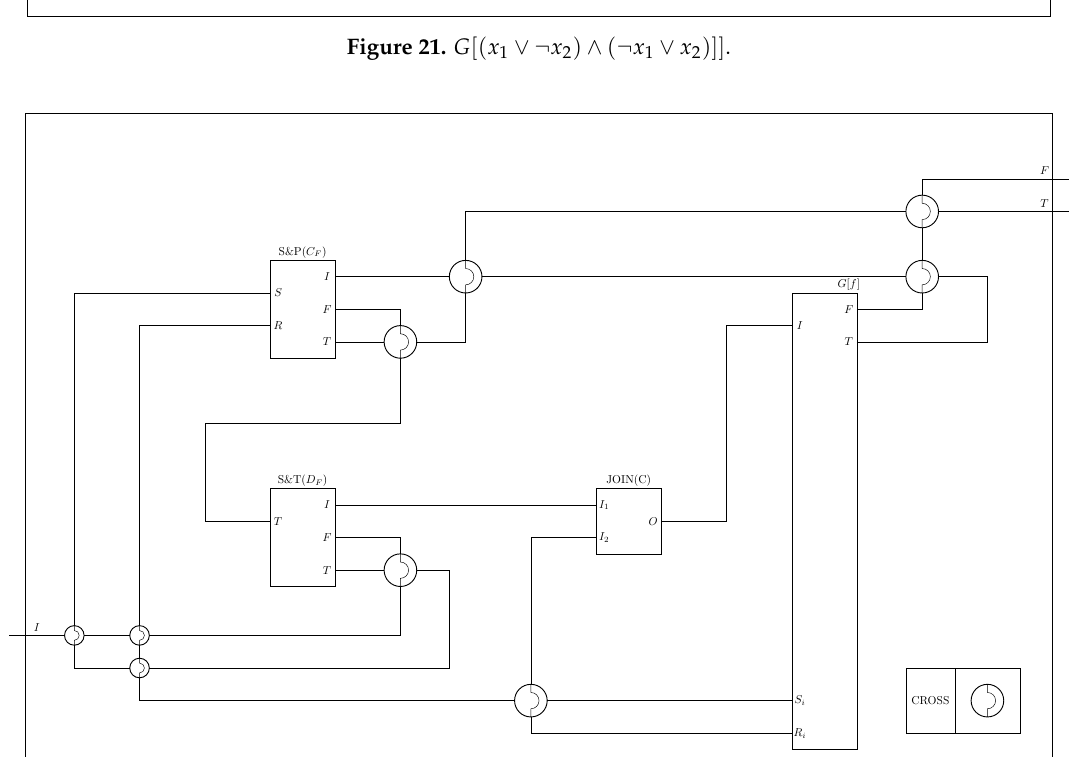
Figure 21. G [( x 1 ∨ ¬ x 2 ) ∧ ( ¬ x 1 ∨ x 2 )]] .